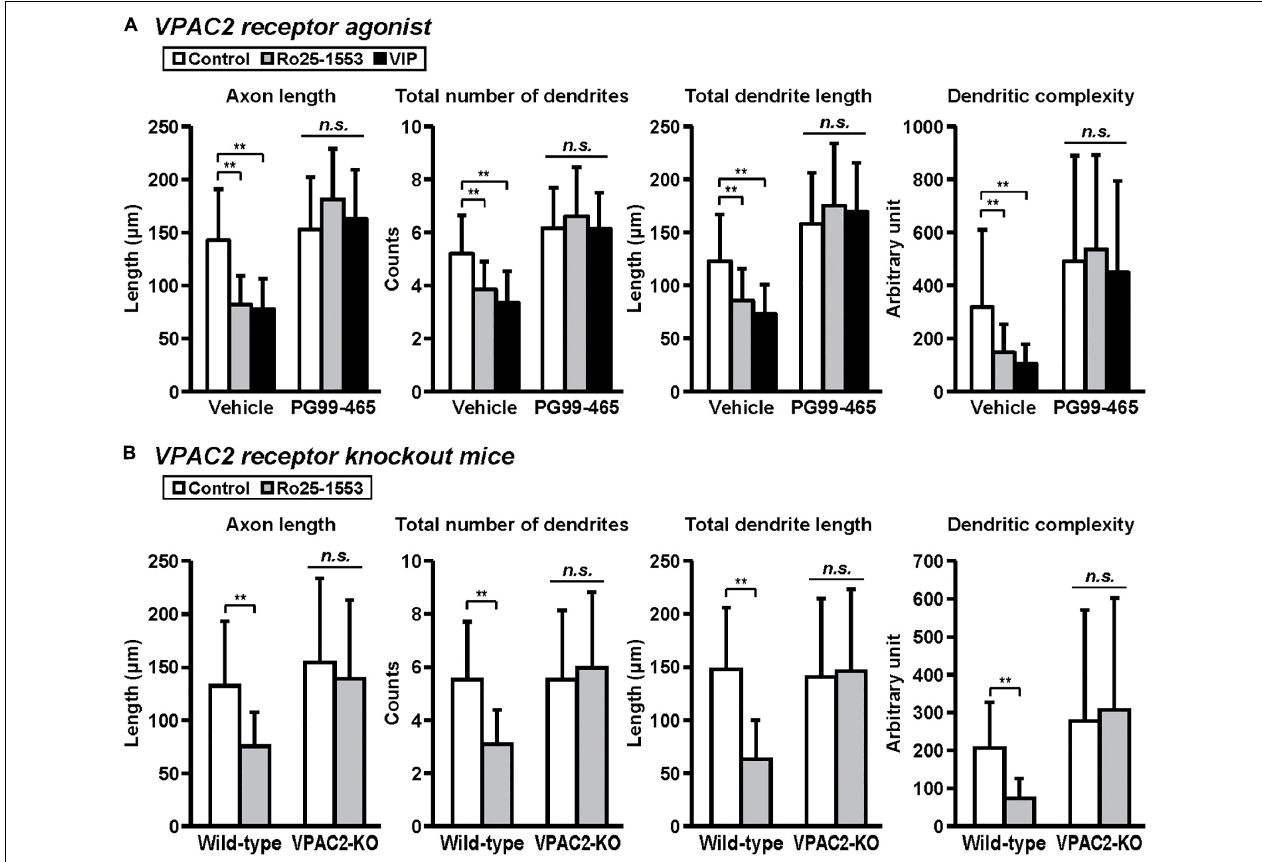
FIGURE 5 | VPAC2 receptor-mediated reductions in axon and dendritic outgrowth in cultured cortical neurons. Primary cortical neurons were cultured with Ro25-1553 (10 nM) or VIP (10 nM) for 3 days in vitro and double-immunostained for pNF and MAP2. (A) PG99-465 (100 nM) was treated 30 min before the treatment with Ro25-1553 or VIP. PG99-465 blocked Ro25-1553- and VIP-induced reductions in axon length (main effects: F 2 , 215 = 8.338, P < 0.001 for Ro25-1553/VIP,